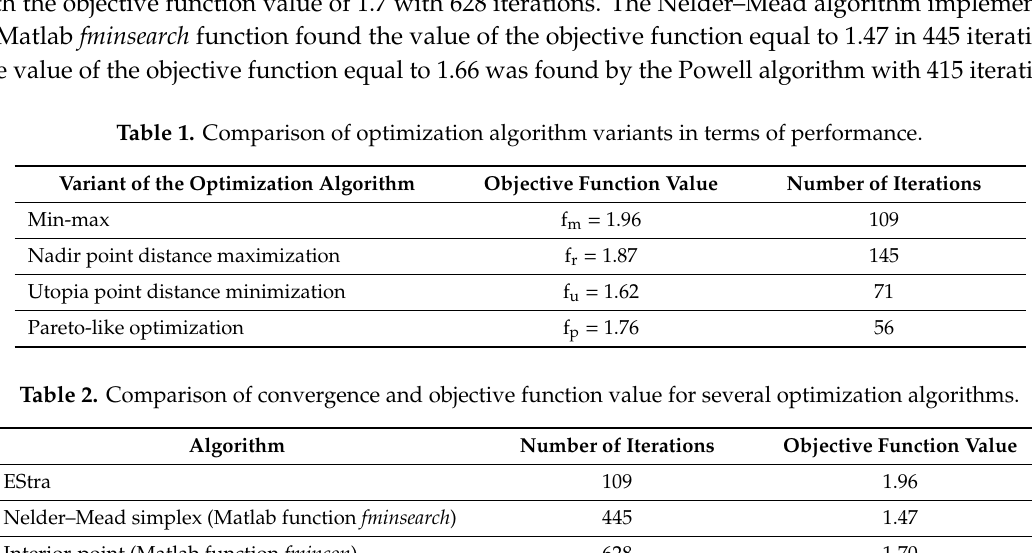
Figure 16. The radiation patterns of the optimized antenna array for all combinations of phasing.